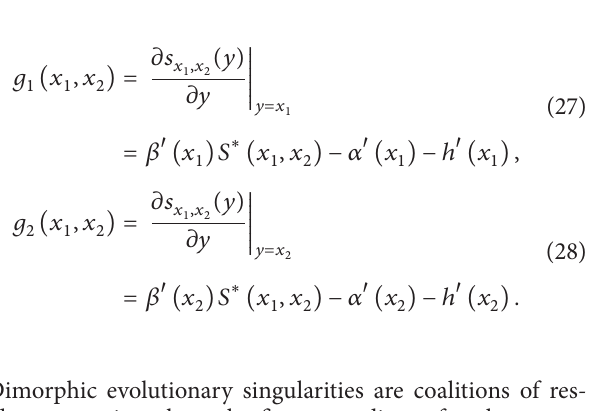
𝐼 𝐼 1 and 2 , one with strain population dynamics is given